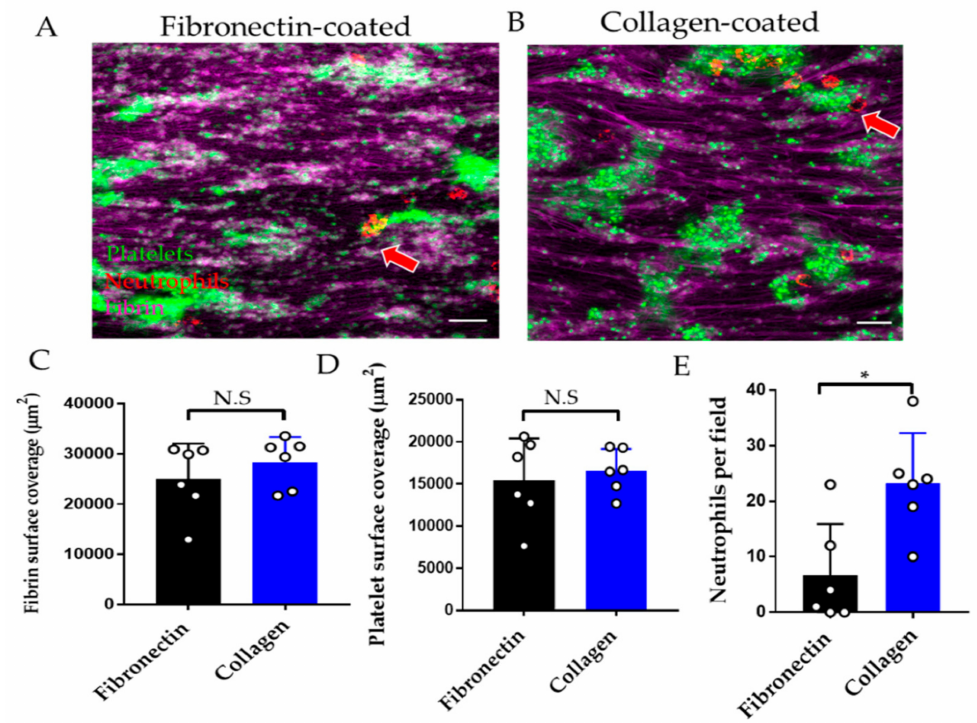
Figure 5. Effect of endothelial substrate on performance of the thromboinflammation chip. Represen- tative images of fibrin (magenta), platelet (green), and neutrophil (red) adhesion on endothelialised chip on ( A ) fibronectin or ( B ) collagen substrate. Red arrows denote the contact of neutrophils with platelet aggregates. ( C ) Fibrin, ( D ) platelet surface coverage, and ( E ) neutrophils per × 40 field on fibronectin coated (black columns) versus collagen-coated (blue columns) endothelialised chips. Data is mean ± SD of six fields of view from n = 3 separate donors. * p < 0.05; N.S = non-significant by two-tailed, paired non-parametric t -test (Wilcoxon).